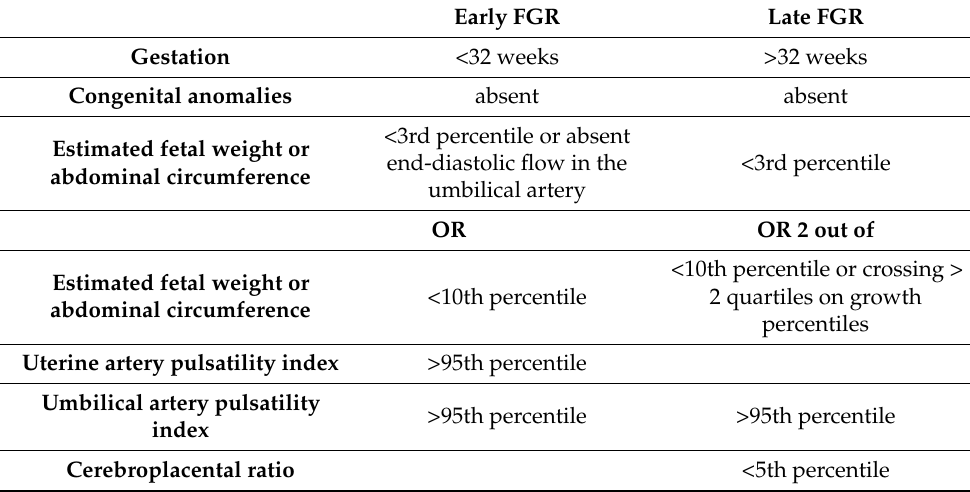
Table 1. Consensus definition of early and late onset